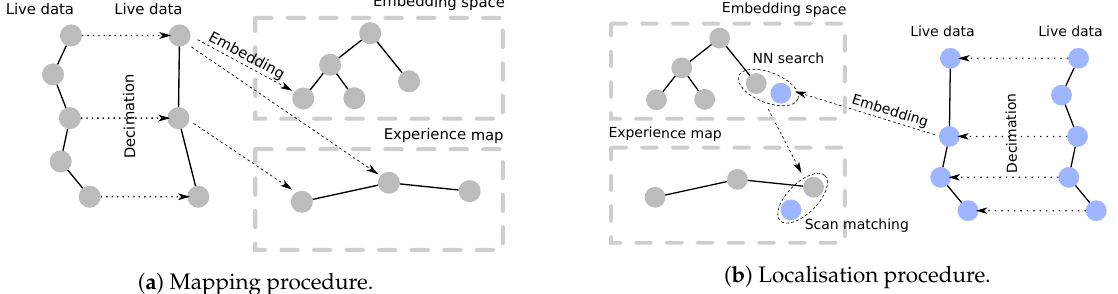
Figure 5. The system is composed of two main phases: mapping ( a ) and localising ( b ). The mapping process entails a two-fold discretisation: one made in a topometric space through an experience map and one made in an embedding space through a kD-tree procedure for fast lookups. Each radar scan in the live data is used to estimate the robot’s motion during both mapping and localisation, but only a portion of them is actually used for localisation. The scans are chosen to be retained through a decimation process, either based on traversed space or time